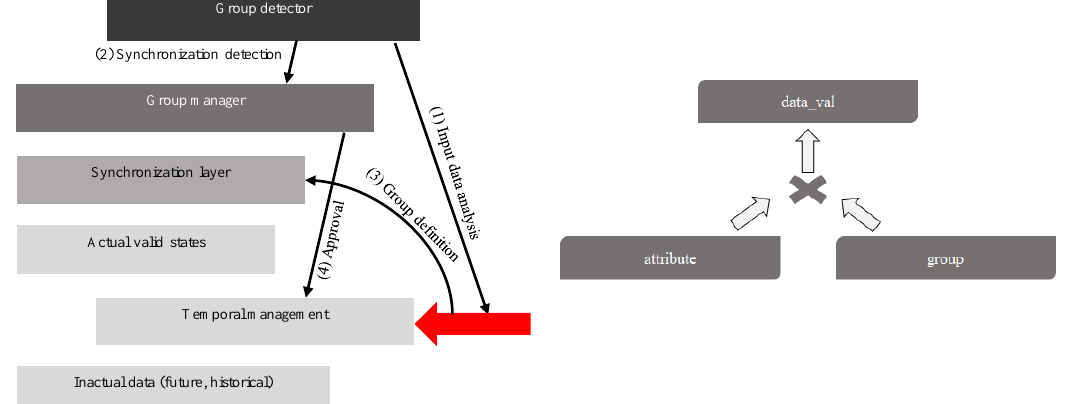
Figure 6. Temporal data grouping—solution architecture.